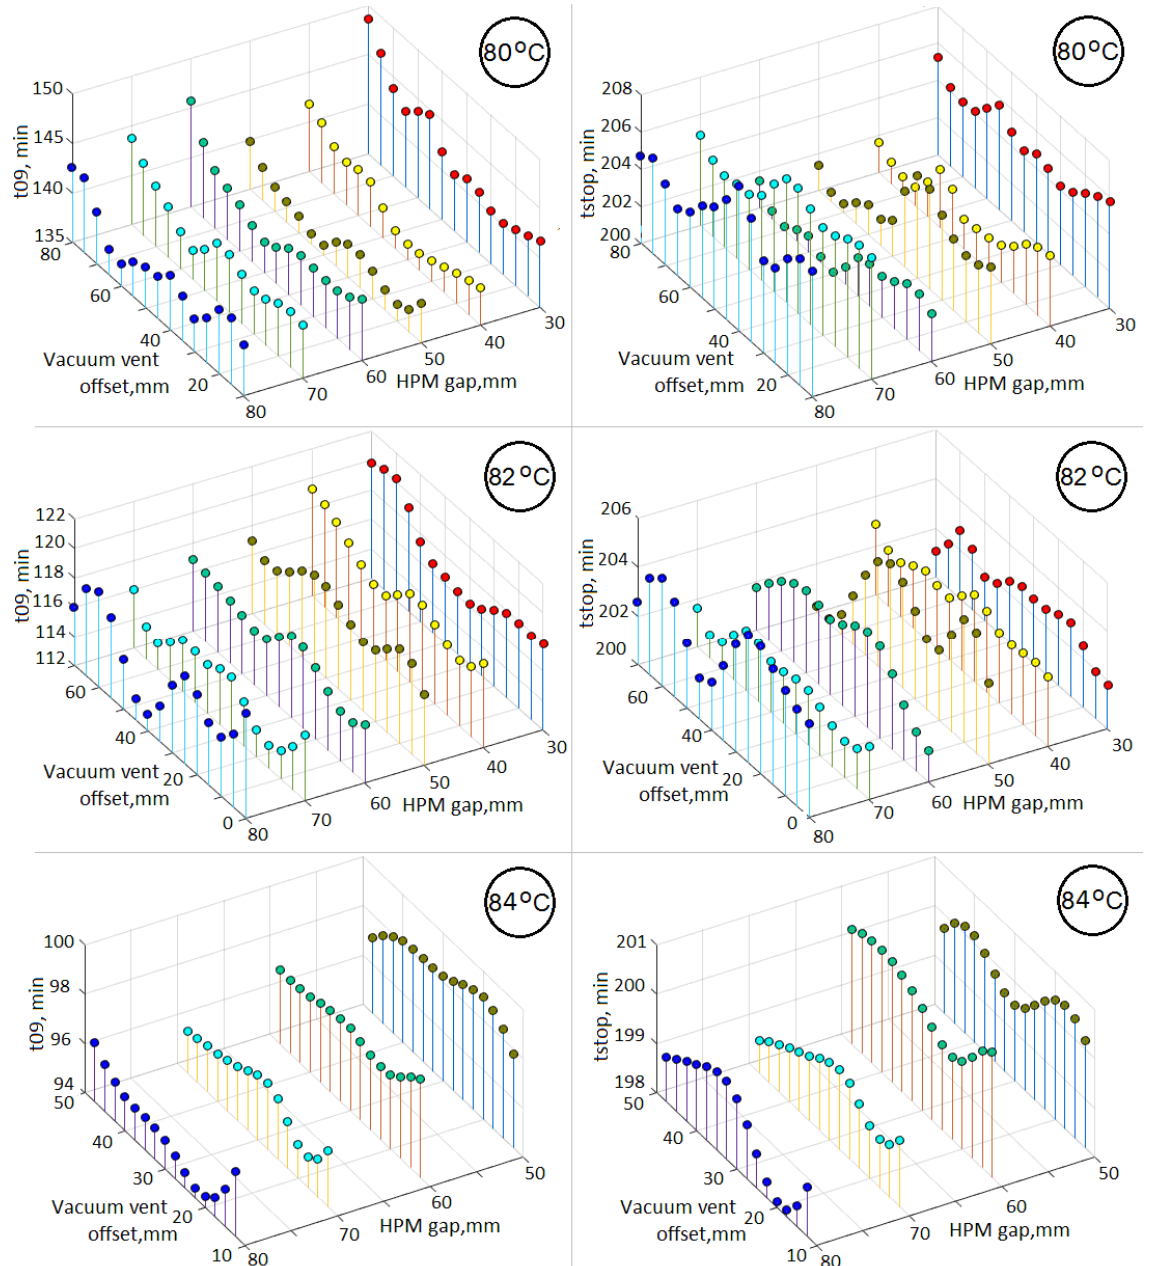
Figure 5. Dependencies of the process duration up to moments t 09 ( left ) and tstop ( right ) at isothermal holding temperatures hold T of 80, 82, and 84 °C on the location of the vacuum vent.